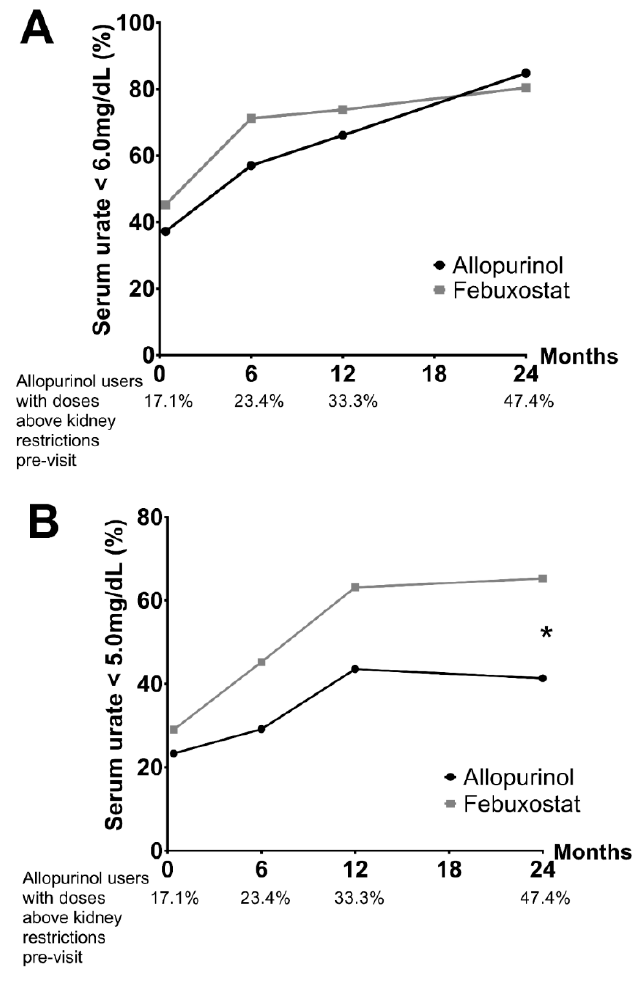
Figure 3. Percentage of patients treated with urate-lowering therapy reaching targeted serum-urate levels. Percentage of patients treated with febuxostat and allopurinol reaching serum-urate levels below ( A ) 6.0 and ( B ) 5.0 mg/dL, and percentage of allopurinol users treated with doses above restrictions according to estimated glomerular-filtration rates before the visit. * p < 0.01 in the mixed model.